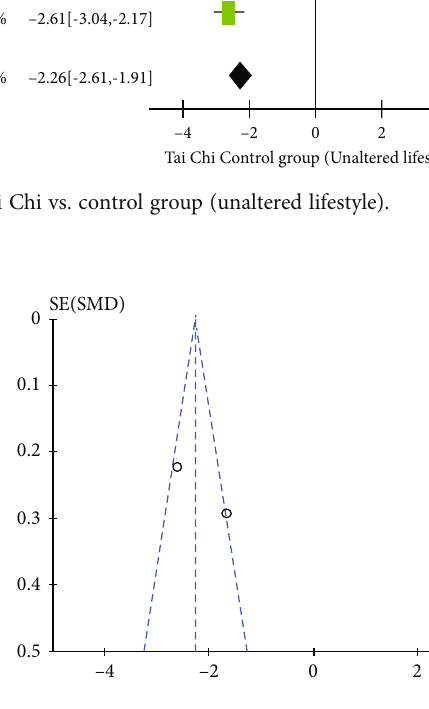
Figure 7: Funnel plot of subgroup analysis of Tai Chi vs. control group (unaltered